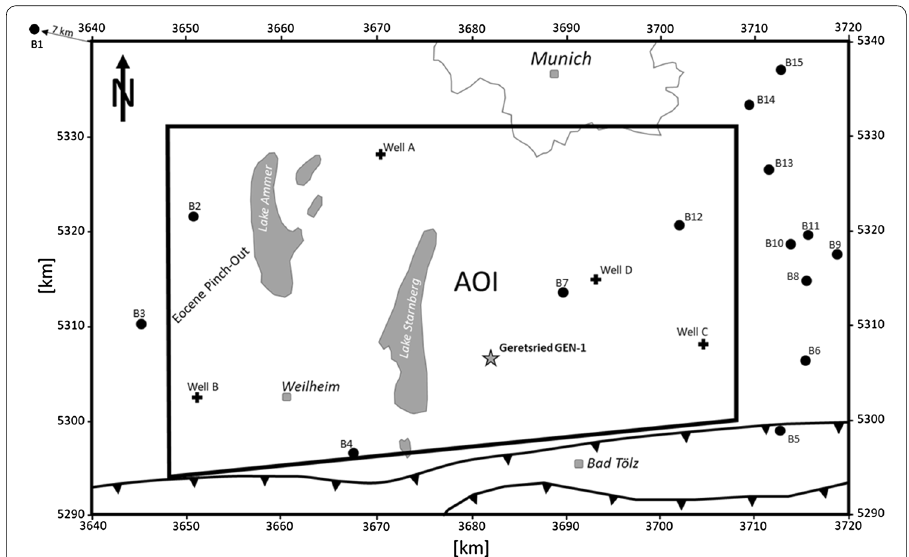
Fig. 4 Study area and extent of 3D basin model with used wells. The Geretsried GEN-1 drill site is marked with a grey star, the calibration wells a – d are marked with black crosses, while black dots indicate additional wells (B1–B15) used to constrain the 3D basin model. One well is outside of the map area and was used to constrain the extent of the Schoeneck Formation. The map coincides with the extent of the full basin model, which has been reduced to an area of interest (AOI, marked by the black lined polygon) after